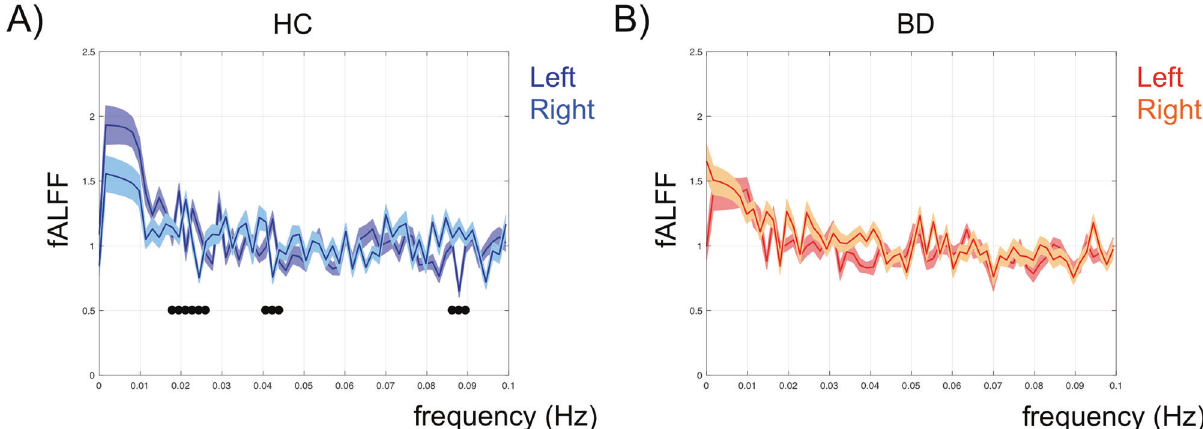
Fig. 4 ROI fALFF in HC and BD patients. Normalized fALFF analysis carried out on left and right ROIs time series (MNI coordinates: -54, 21, 6 and 54, 21, 6, respectively) in HC ( A ) and BD patients ( B ) (blue/light-blue and red/orange lines,